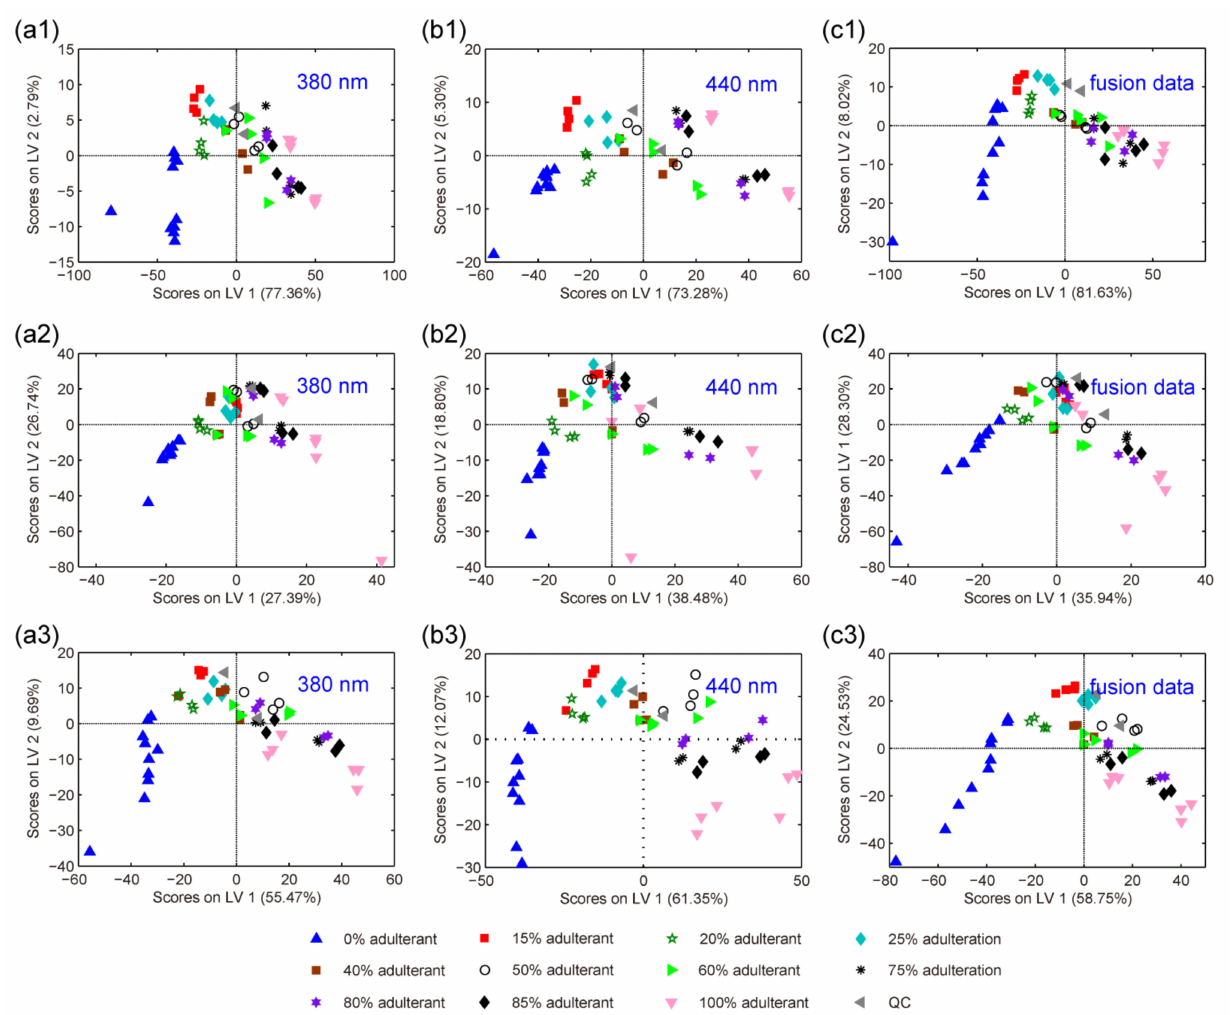
Figure 3. PLS-DA score plots of LV1 versus LV2, using first-order fingerprint data collected at 380 nm ( a1 – a3 ), first-order fingerprint data collected at 440 nm ( b1 – b3 ), and first-order fusion fingerprint data generated by DVF ( c1 – c3 ) in Sichuan EJT adulterated with Guizhou EJT (case 1), Guizhou LT adulter- ated with Henan LT (case 2), and Guizhou WZ adulterated with Guizhou PD (case 6),